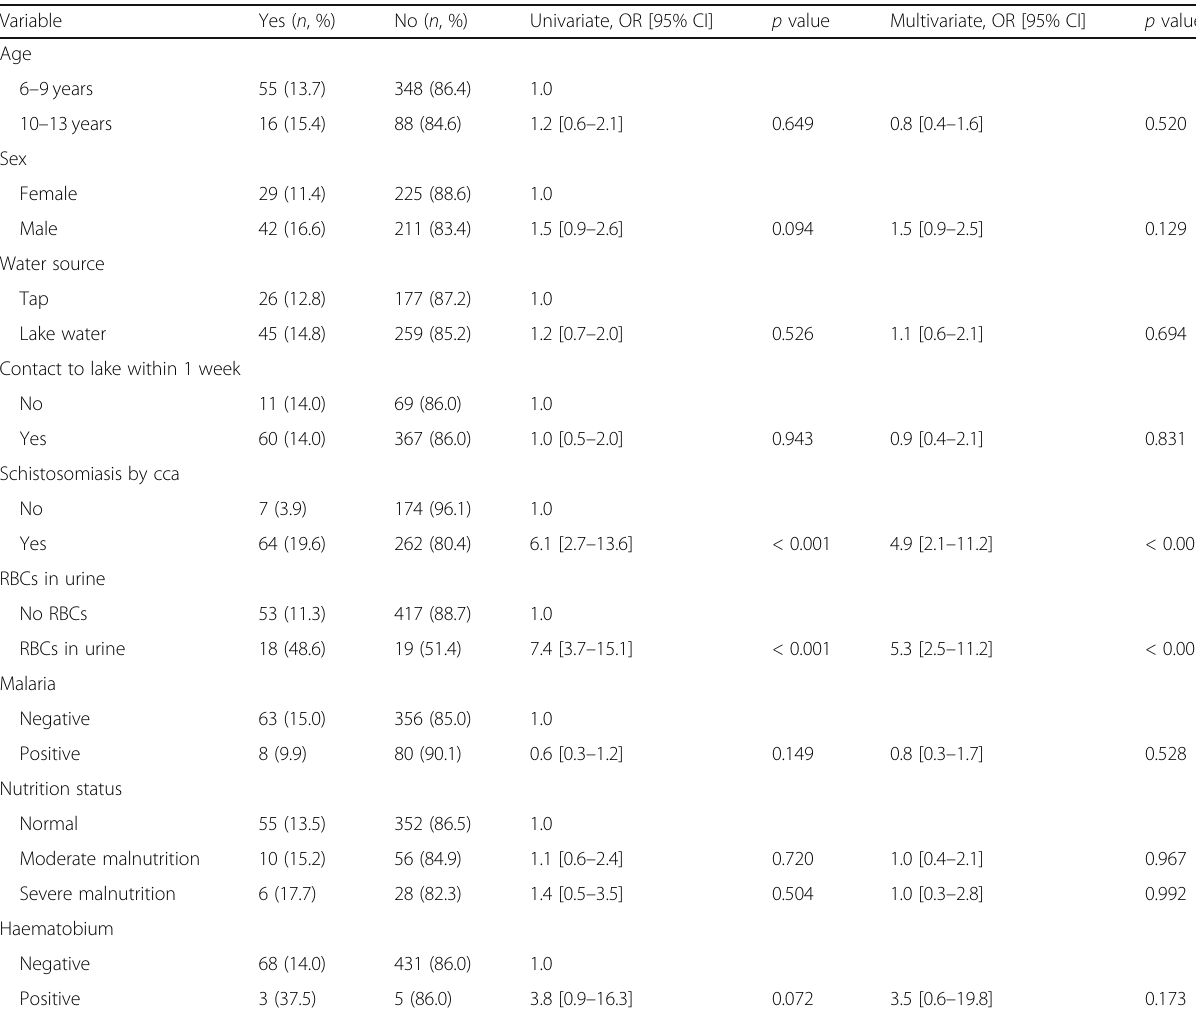
Table 3 Factors associated with proteinuria